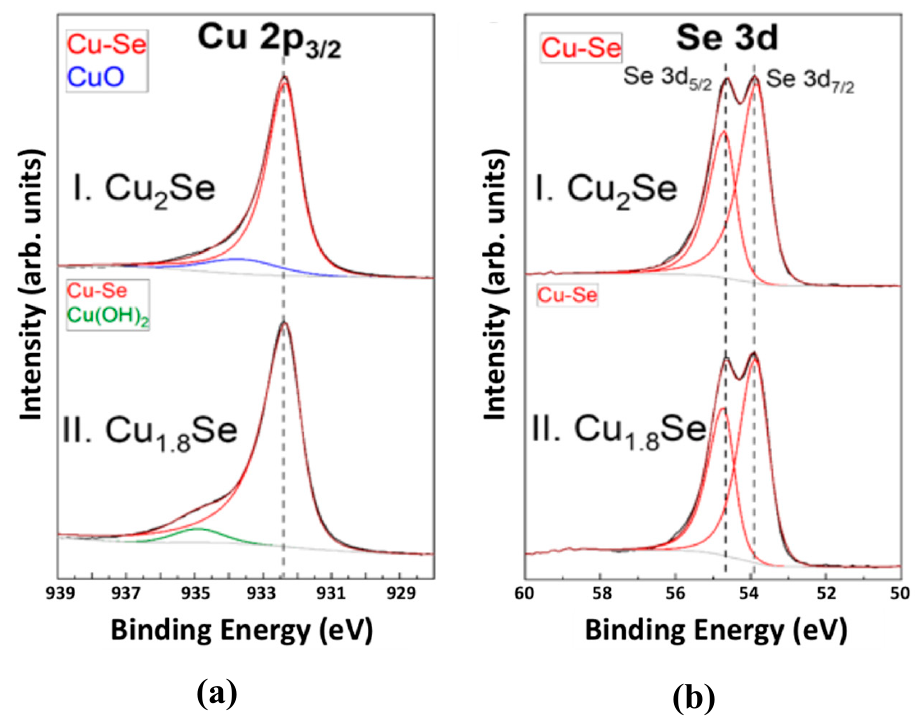
Figure 3. X-ray photoelectron spectroscopy (XPS) high-resolution spectra with peak fitting for ( a ) Cu 2p 3 / 2 and ( b ) Se 3d regions for (I) Cu 2 Se and (II) Cu 1.8 Se bulk samples. Various peaks shown represent various species assumed to exist. Labels and peak colors are correlated. The global atomic percentages and the fitting results for Cu 2p 3 / 2 and Se 3d regions are summarized in Table S1, Table 2, and Table S3, respectively. Table 2. XPS peak fitting results for Cu 2p 3/2 region for SPS sintered bulk samples.